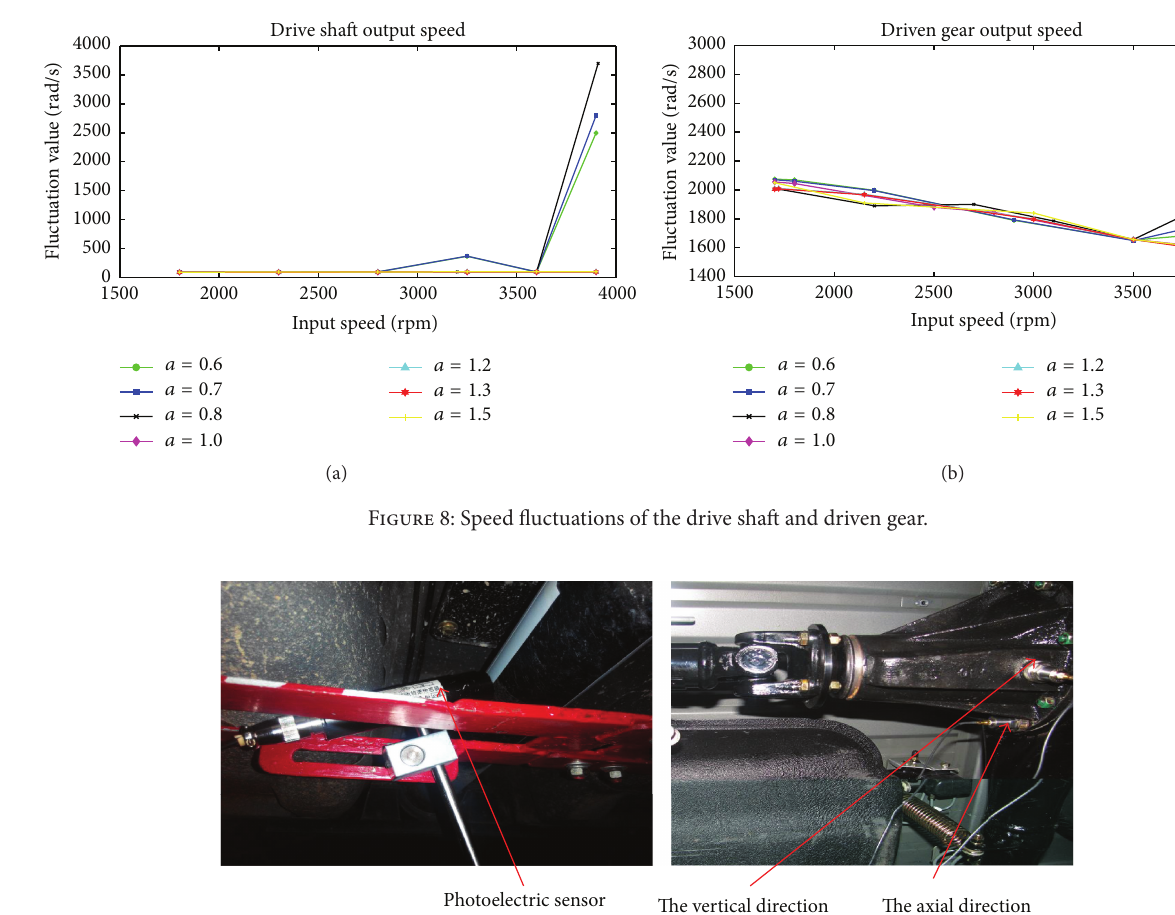
Figure 9: Layout and installation of two